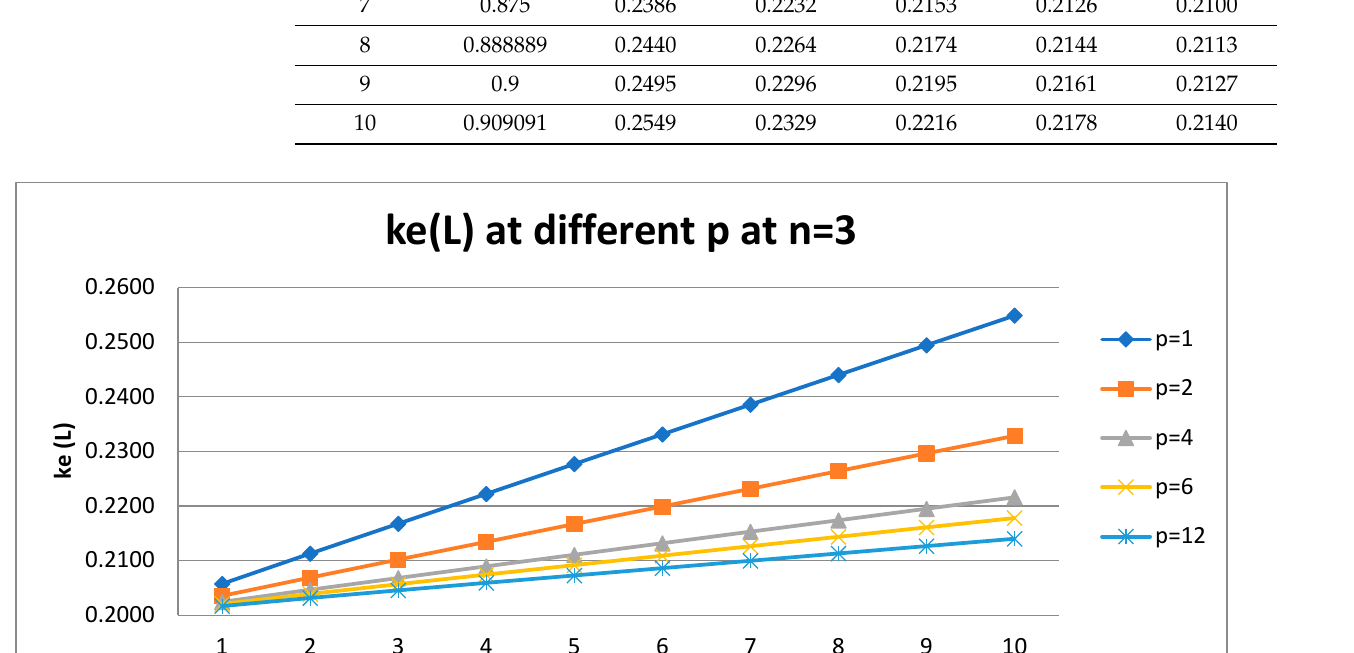
Figure 6. Dependence of the equity cost, k e , on leverage level L at different frequency of payments of tax on profit p for three-year company.